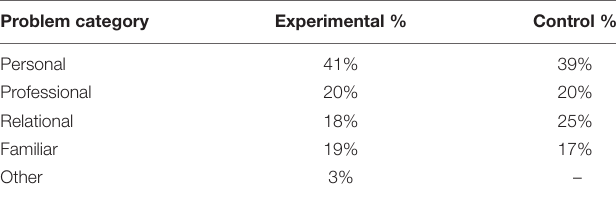
TABLE 4 | Words in participants’ texts as a function of writing task.